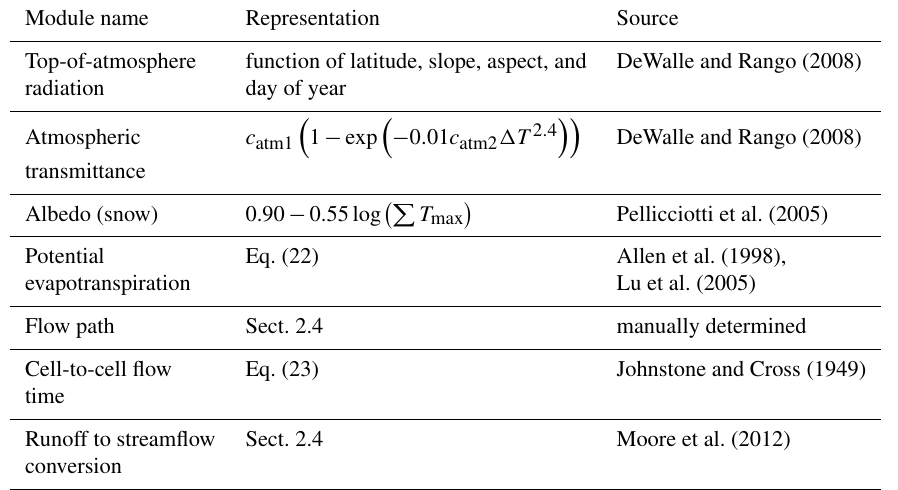
Table 2. Process representations for modules that are fixed in the present CCHF implementation. c atm1 and c atm2 are fitting parameters (unitless), (cid:49)T is maximum temperature minus minimum temperature ([ (cid:49)T ] = K), and P T max is the cumulative sum of maximum daily temperatures since the last precipitation event ([ P T max ] = K). Albedo of exposed ice is assumed to be